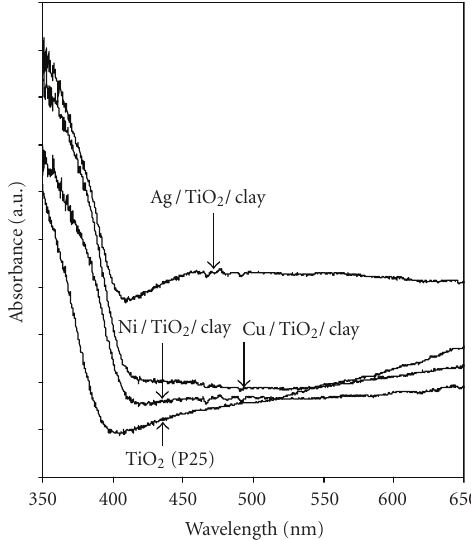
Figure 9: Di ff use reflectance UV-Vis spectra of exchanged Na- montmorillonite/TiO 2